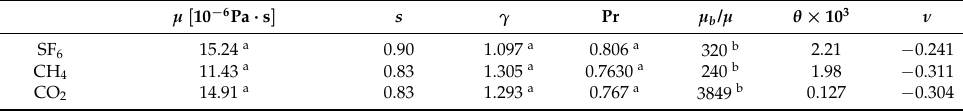
µ [ 10 − 6 Pa · s ] s γ Pr µ b /